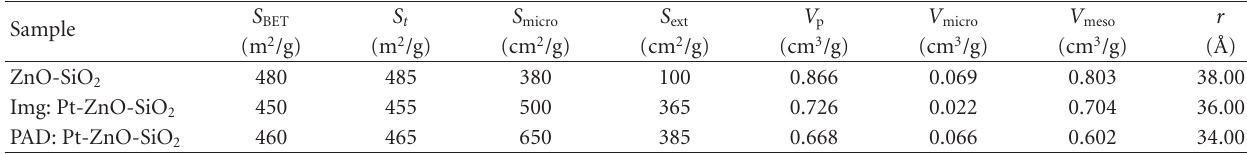
Table 1: Texture parameters of ZnO-SiO 2 , Img: Pt-ZnO-SiO 2 , and PAD: Pt-ZnO-SiO 2 . Sample